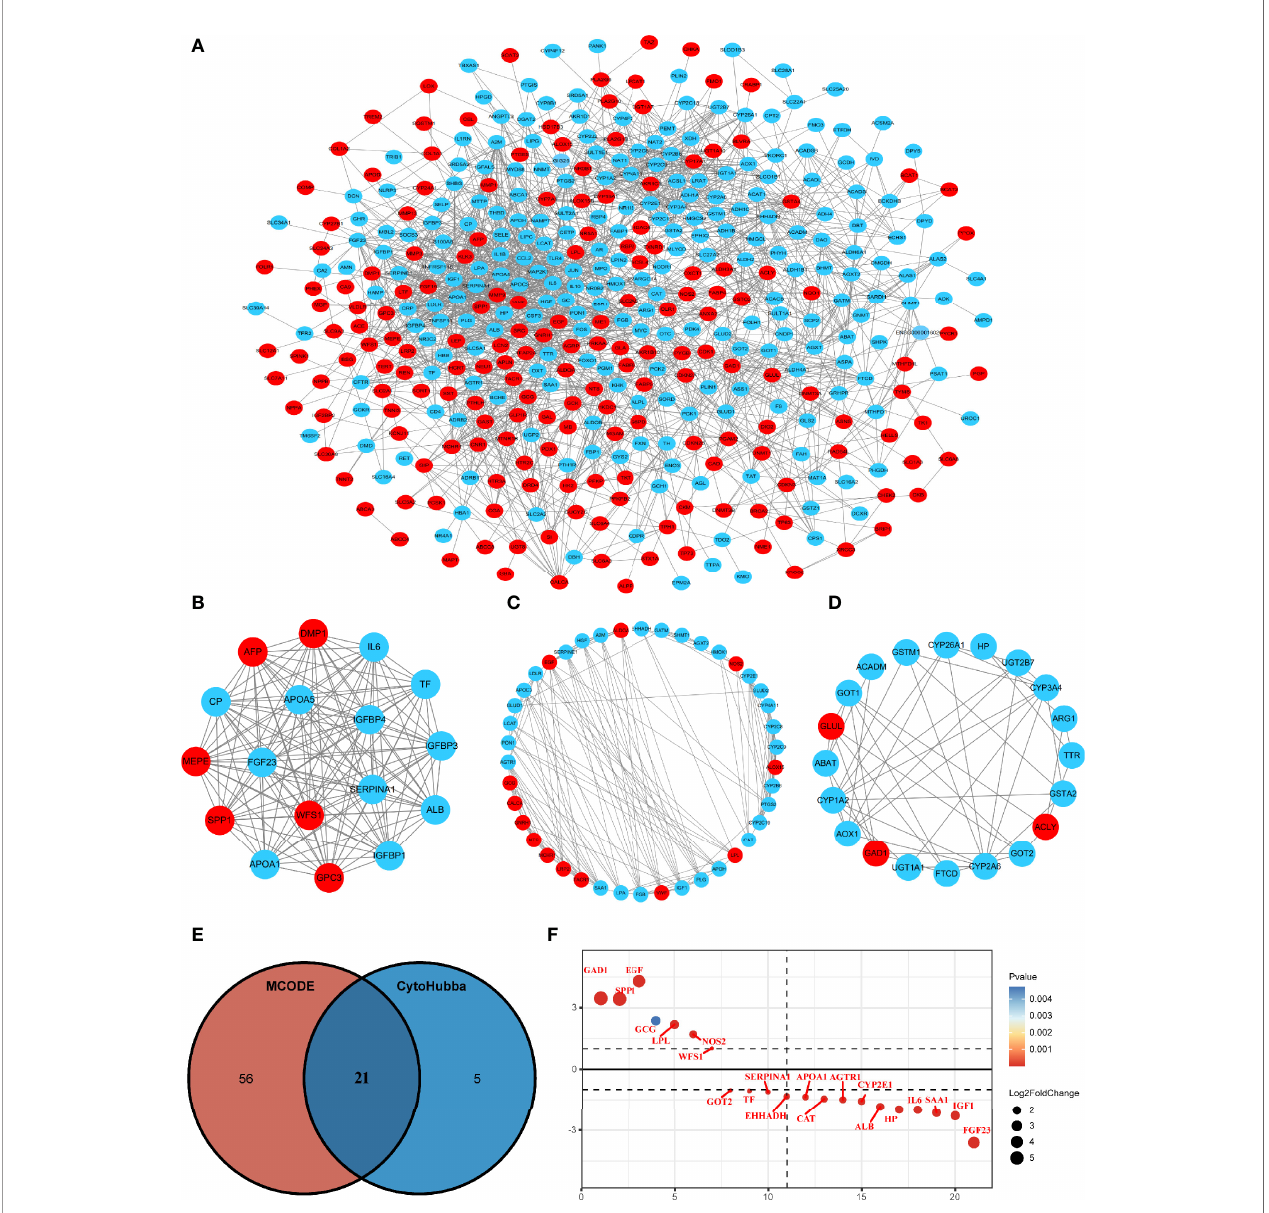
FIGURE 2 | Protein-protein interaction (PPI) network construction and hub gene screening. (A) The interaction network between proteins coded by MRGs comprised 423 nodes and 2193 edges. Red circles represent upregulated genes and blue circles represent downregulated genes. (B – D) Three cluster modules were extracted by MCODE in PPI networks. (E) Venn diagram showing the hub genes obtained by intersecting the MCODE and cytoHubba algorithms. (F) Differential expression ranking of 21 hub